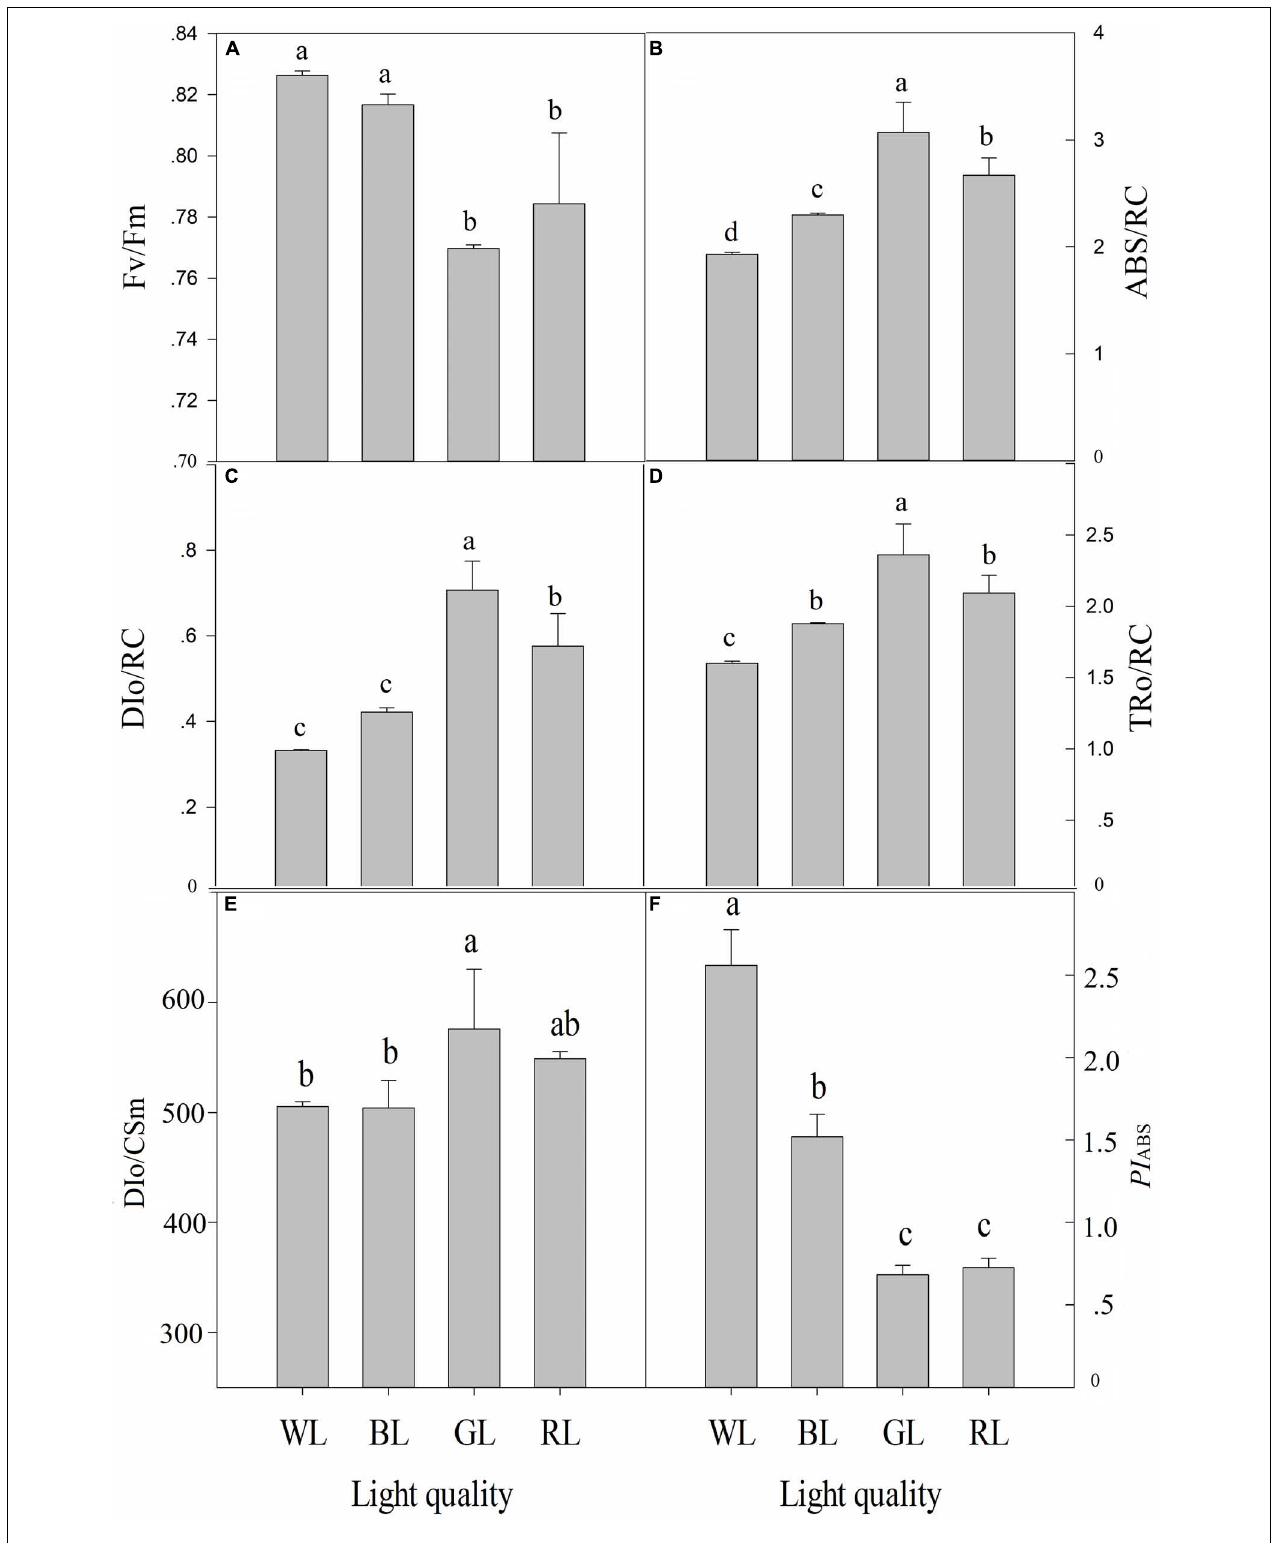
FIGURE 6 | Effects of light quality on chlorophyll fluorescence parameters [Fv/Fm (A) , ABS/RC (B) , DIo/RC (C) , TRo/RC (D) , DIo/CSm (E) and PI ABS (F) ] in C. paliurus leaves (Means ± SD). Different letters indicate significant differences ( P < 0.05) between LED light treatments according to ANOVA and LSD test, n = 3.